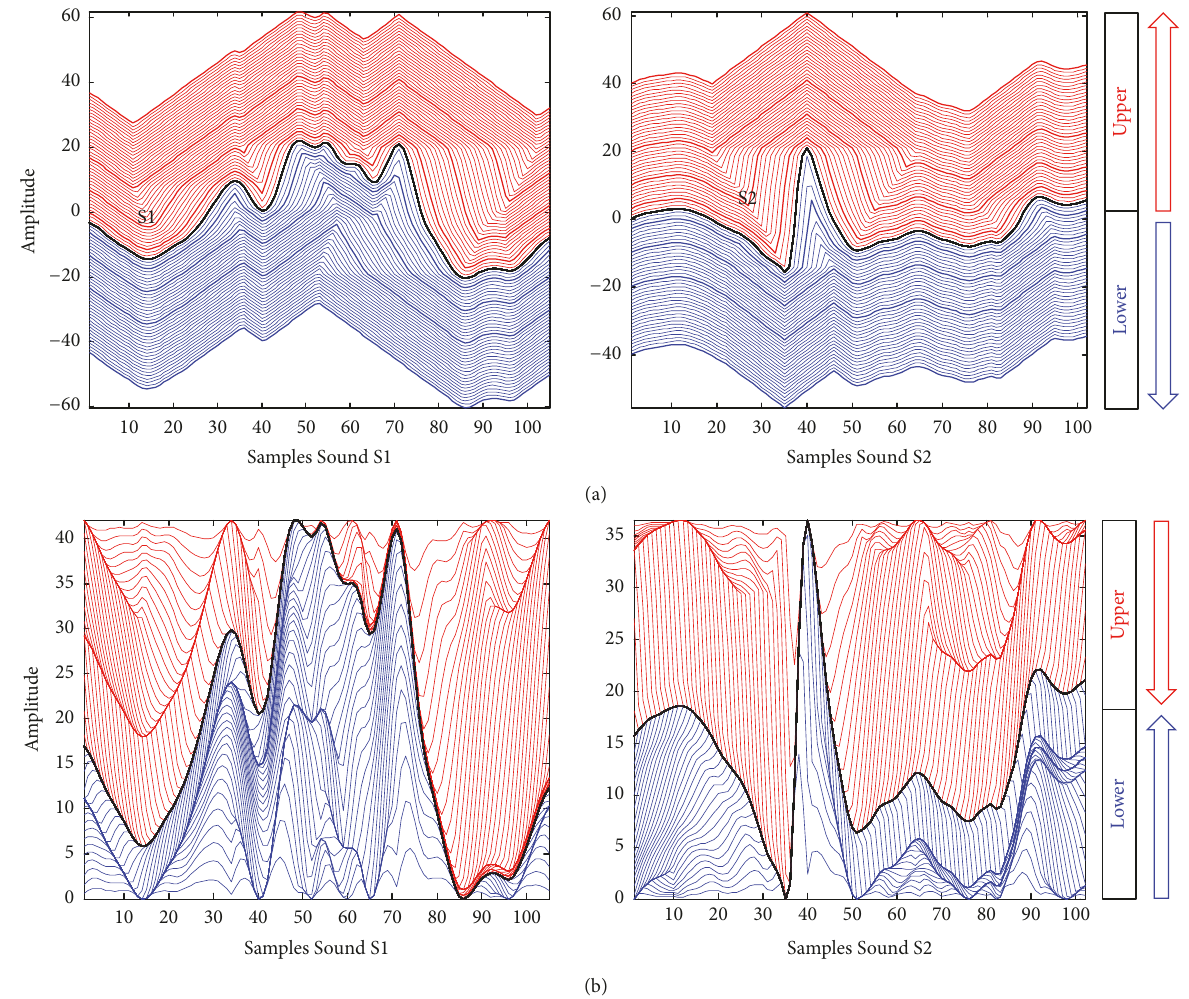
Figure 2: The upper and lower envelopes: (a) moving from the original structure used in BFD1, with forty iterations presented; (b) moving towards the structures according to the adapting technique: (4a), (4b), (5a), and